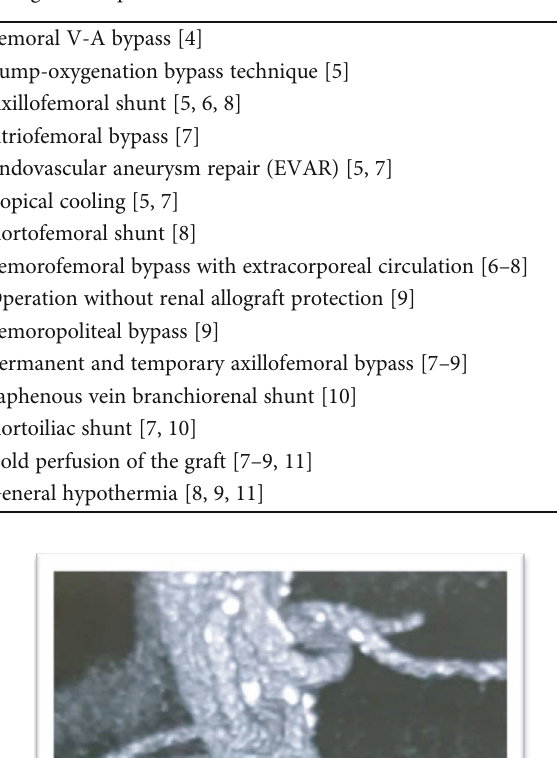
Table 1: Techniques used for protection of the transplanted kidney during AAA repair.